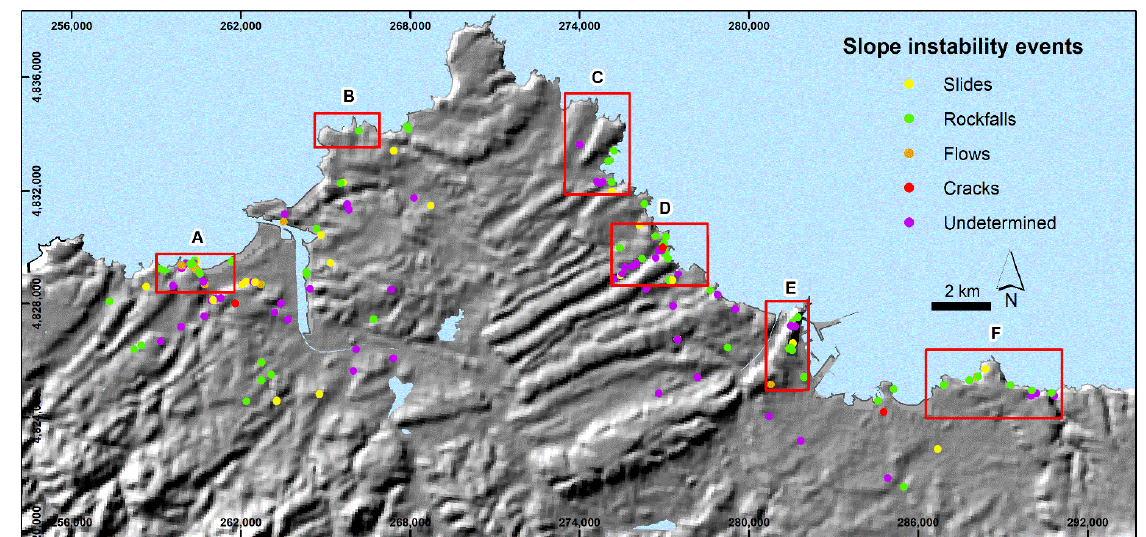
Figure 3. Geographical distribution of coastal slope instabilities registered in the BAPA database [46] between 1980 to 2019. Red rectangles indicate areas studied more in depth: A-Salinas Town, B-Podes Peninsula, C-Luanco Town, D-Candás Town, E-Musel Port and F-Peñarrubia Beach. DEM with 5 × 5 m pixel resolution.